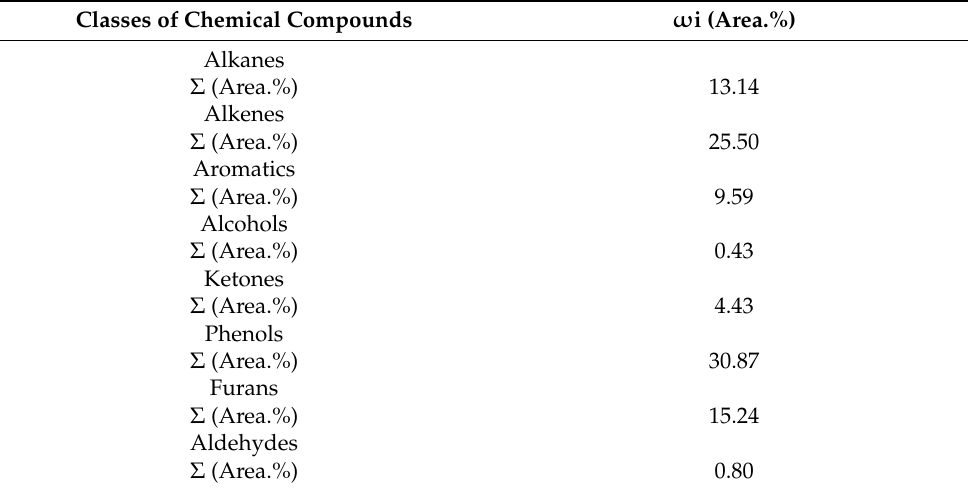
Table 9. Classes of compounds and summation of peak areas of hydrocarbons and oxygenates identified by CG-MS in bio-oil obtained in bench